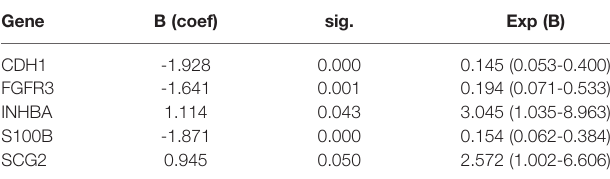
TABLE 2 | Cox regression analysis